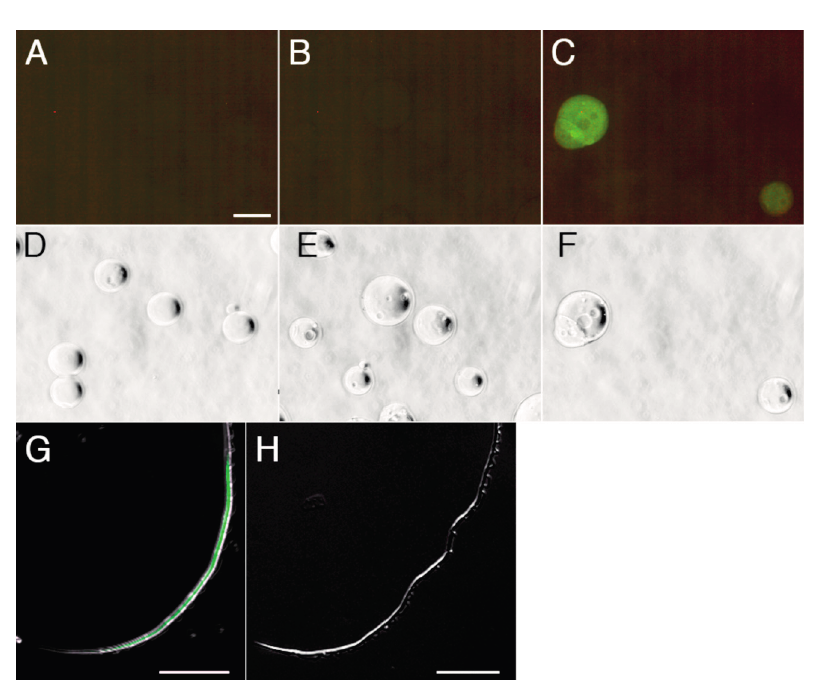
Figure 8. Binding specificity of Alexafluor 488-labeled AEBSF for serine and cysteine proteases. Alexafluor 488-labeled AEBSF was prepared by a covalent binding of Alexafluor 488 to the amino group of AEBSF. ( A – F ) Alexafluor 488-labeled AEBSF was treated with trypsin-conjugated agarose beads ( A , D ), chymotrypsin-conjugated agarose beads ( B , E ), or papain-conjugated agarose beads ( C , F ). ( D – F ) Bright field of panels ( A – C ), respectively; ( G , H ) Merged images of dark field and fluorescence of principal piece of the sperm treated with Alexafluor 488-labeled AEBSF ( G ) or co-treated with Alexafluor 488-labeled AEBSF and papain ( H ). Bar: 25